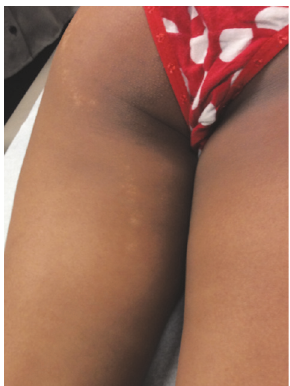
Figure 2: Hypopigmented macules coalescing into patch along BL.